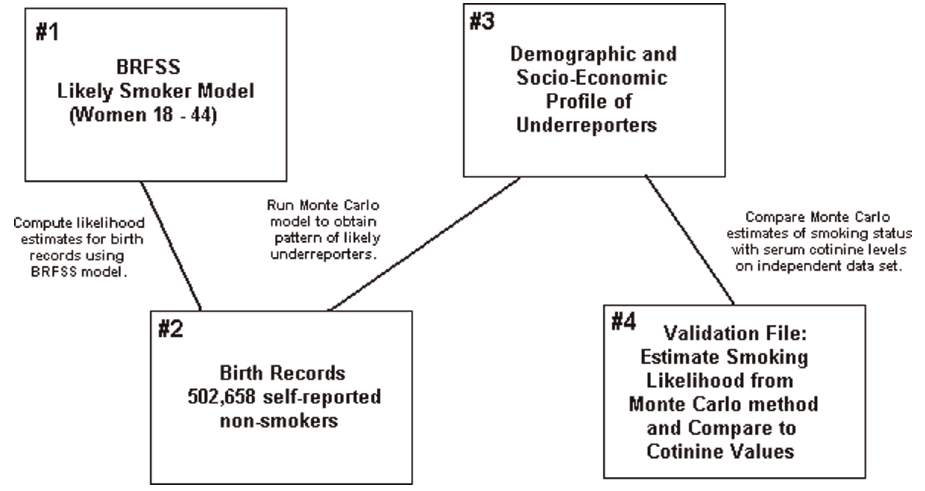
Figure 1. Logic behind the analysis in the paper.